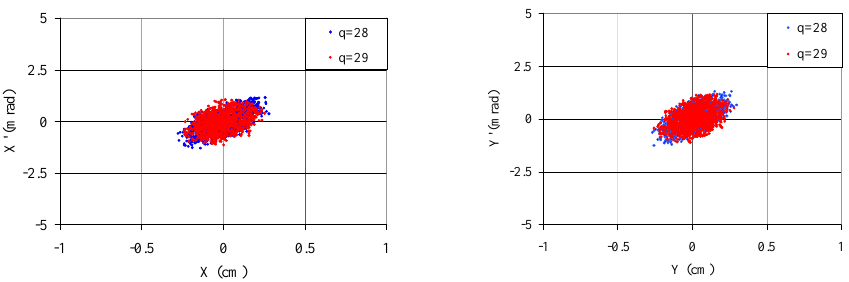
FIG. 10. (Color) Transverse phase space plots of the uranium beam with charge states 28 and 29 simulated through 42 QWRs modified as shown in Fig. 8.